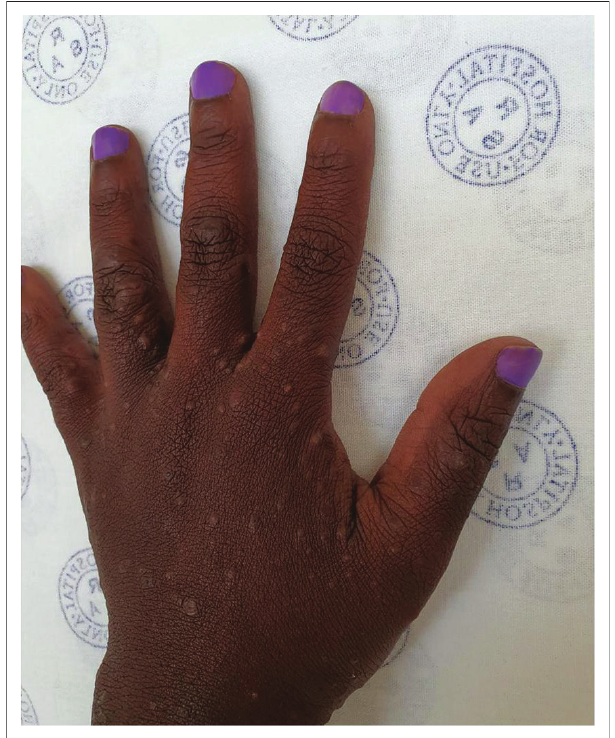
FIGURE 1: Scabies papules on the dorsum of the hand, note the involvement of the web spaces.